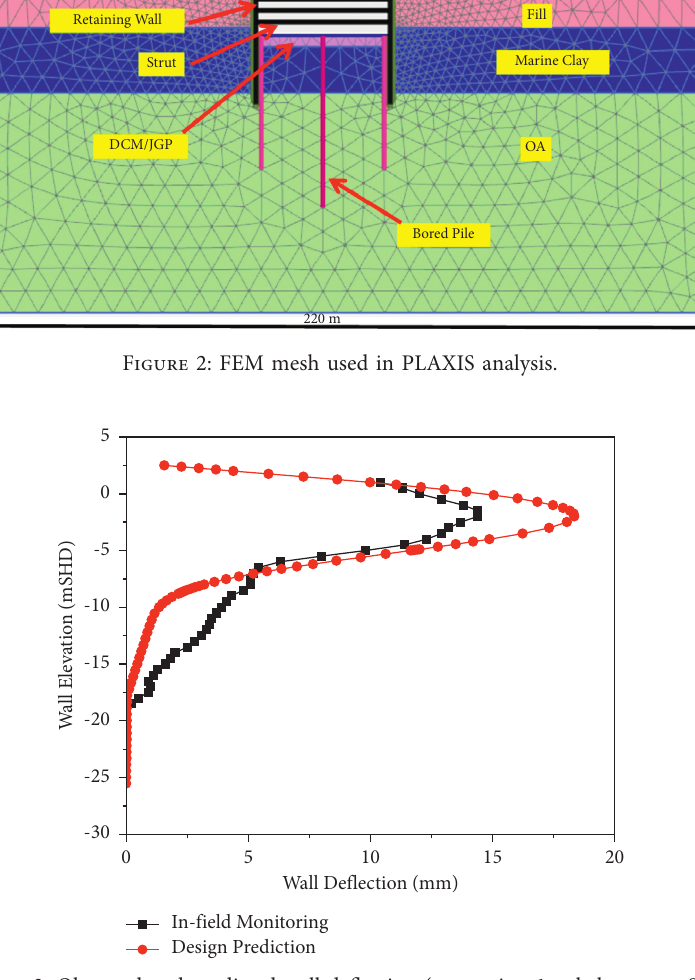
Figure 3: Observed and predicted wall deflection (excavation 1m below strut S